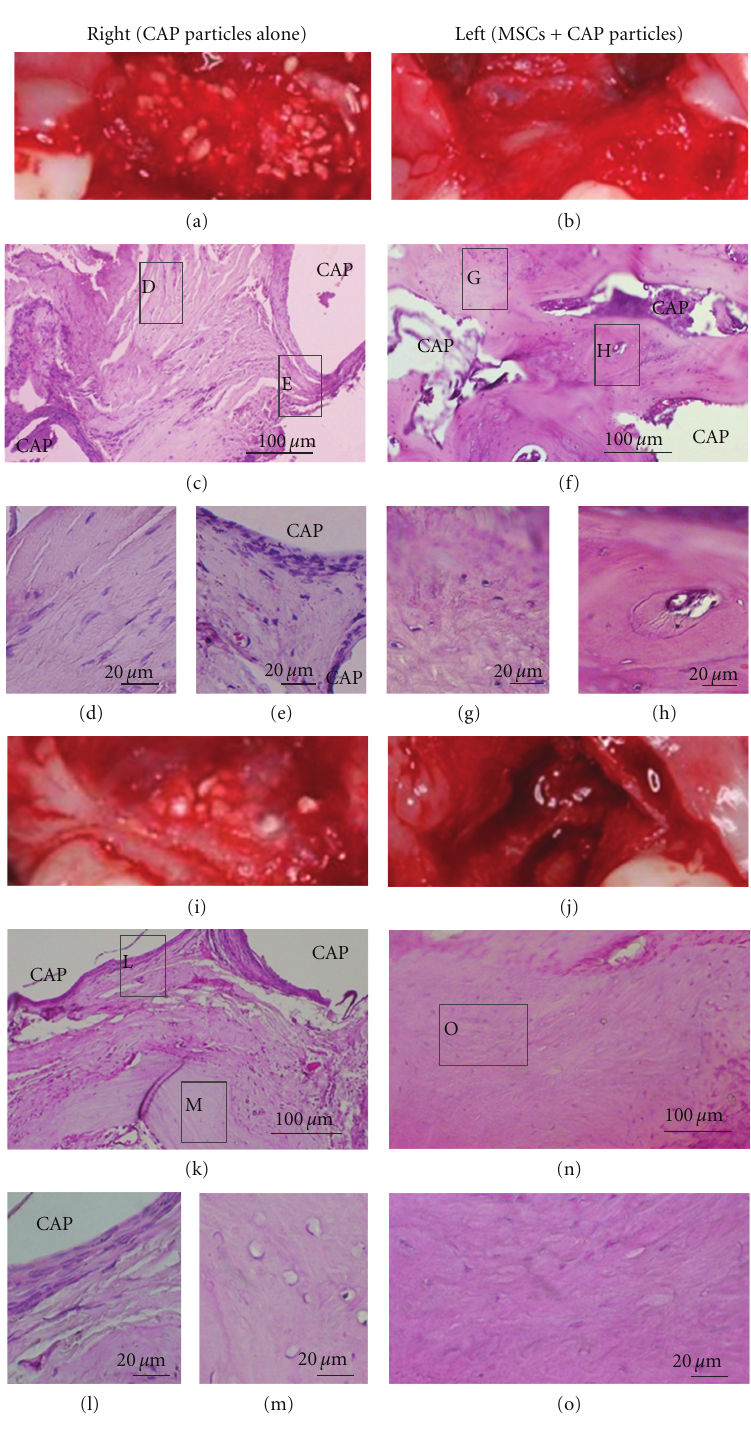
Figure 4: Histological observation before and after the transplantation of MSCs to artificial jaw cleft. The regenerated tissues were separated 3 and 6 months after the transplantation. Tissue sections were made and stained with hematoxylin and eosin (HE). Intraoral images 3 months after the transplantation on (a) the control side (CAP alone) and (b) the experimental side (MSCs and CAP particles). The tissue section showed fibroblastic cells and inflammatory cells around CAP particles on the control side (c, d, and e). New bone formation was shown widely on the experimental side (f, g, and h). Intraoral images 6 months after the transplantation on (i) the control side and (j) the experimental side. The tissue section showed that new bone formation had occurred locally on the control side (k, l, and m). On the other hand, new bone formation was observed in almost the whole area on the experimental side (n and